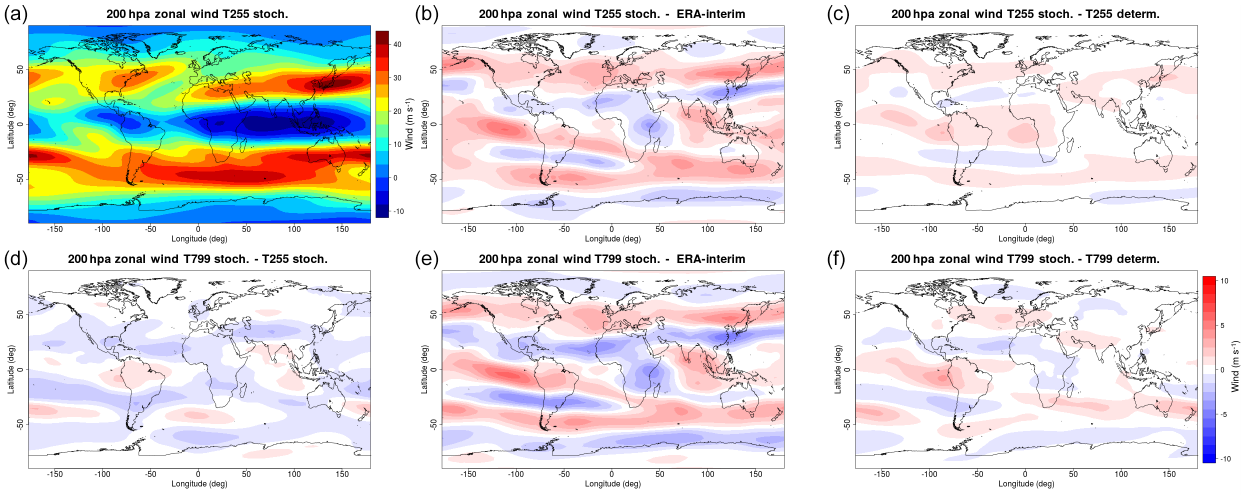
Figure 6. Same as Fig. 5 but for zonal wind at 200hPa. Here bias is evaluated against ERA-Interim